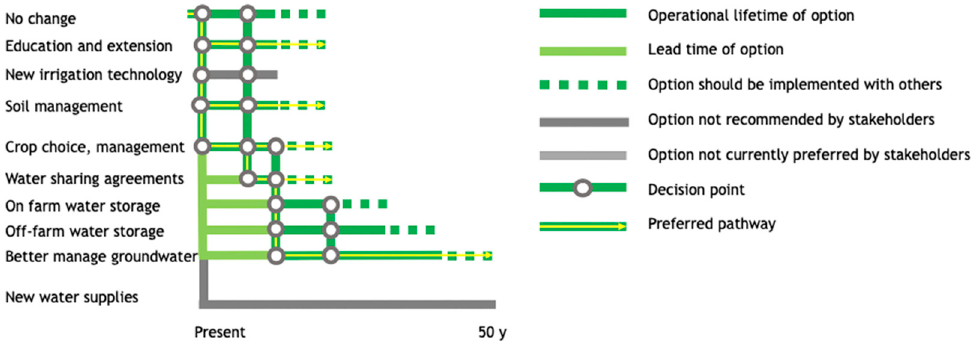
Figure 6. An example of a summary diagram of adaptation pathways for agricultural water use in Hawkes Bay, New Zealand. Adapted from [98].